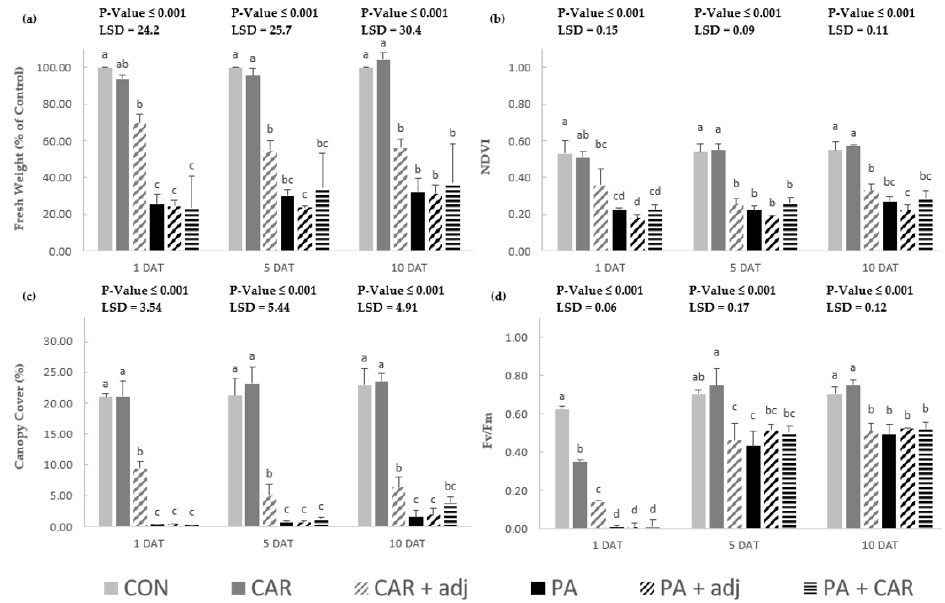
Figure 1. Barnyardgrass ( Echinochloa crus-galli (L.) P.Beauv.) ( a ) fresh weight (% of control), ( b ) NDVI, ( c ) canopy cover (%), and ( d ) maximum quantum yield of photosystem II (F v /F m ). Data are shown as pooled over experimental runs and reanalyzed by one-way ANOVA. Treatment means were separated according to Fischer’s least significant difference (LSD test) at a confidence interval of a = 0.05. For each measurement, different lowercase letters indicate significant differences between treatments. Vertical bars indicate standard errors.